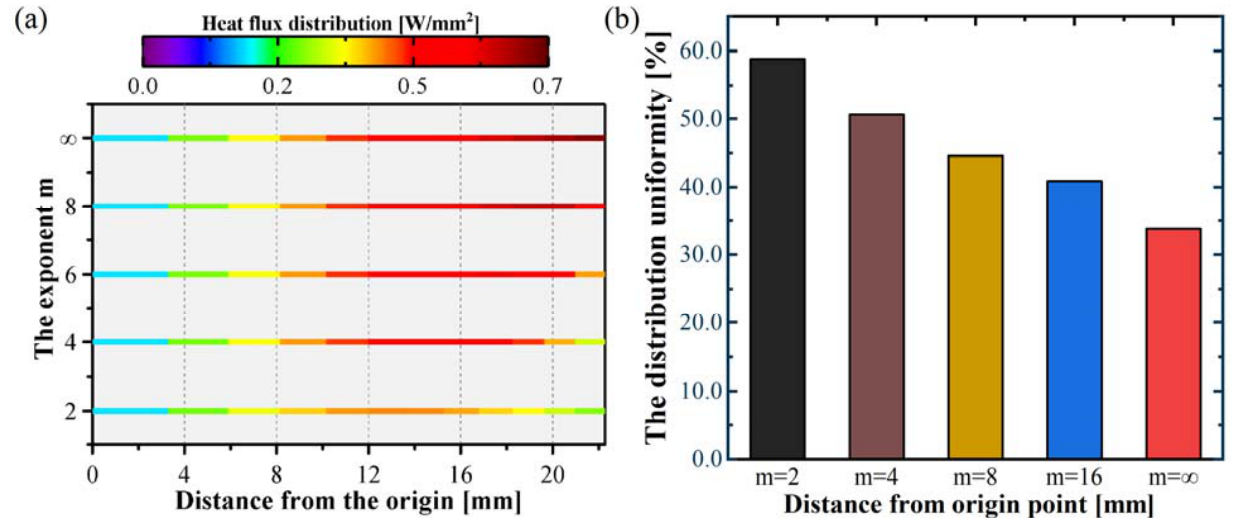
Figure 15. The influence of the exponent m on the heat flux distribution ( a ) and the distribution uniformity ( b ).